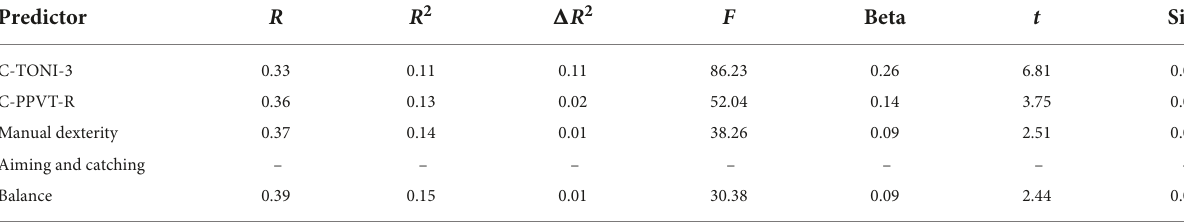
TABLE 6 Linear regression analysis for the predictive effect of subtest of MABC2 on digits RAN. Predictor